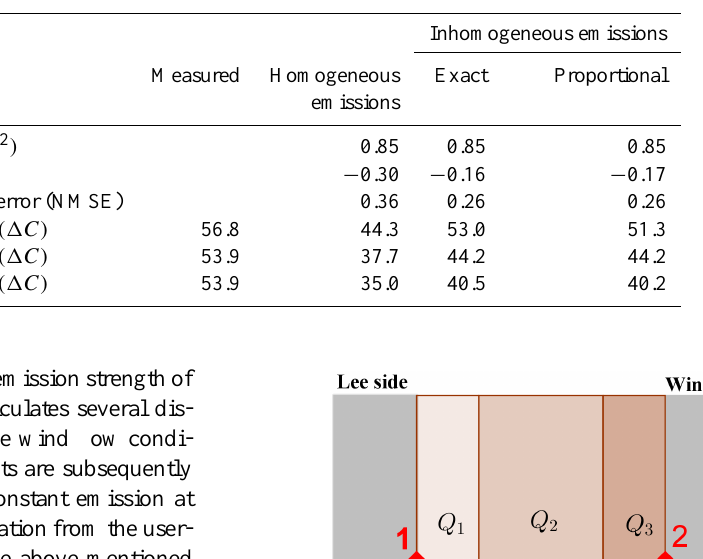
Table 5. Correlation coefficient, fractional bias, and normalised mean square error for the years 2007–2009 for the north side receptor. “Exact” and “Proportional” refer to the emission modelling approaches described in Sect. 2.1. Moreover, the measured and modelled annual mean NO x concentrations for the individual years are also shown. These are calculated as local street contribution only i.e. the background concentration subtracted from the measured/modelled street concentration to reflect the street contribution.